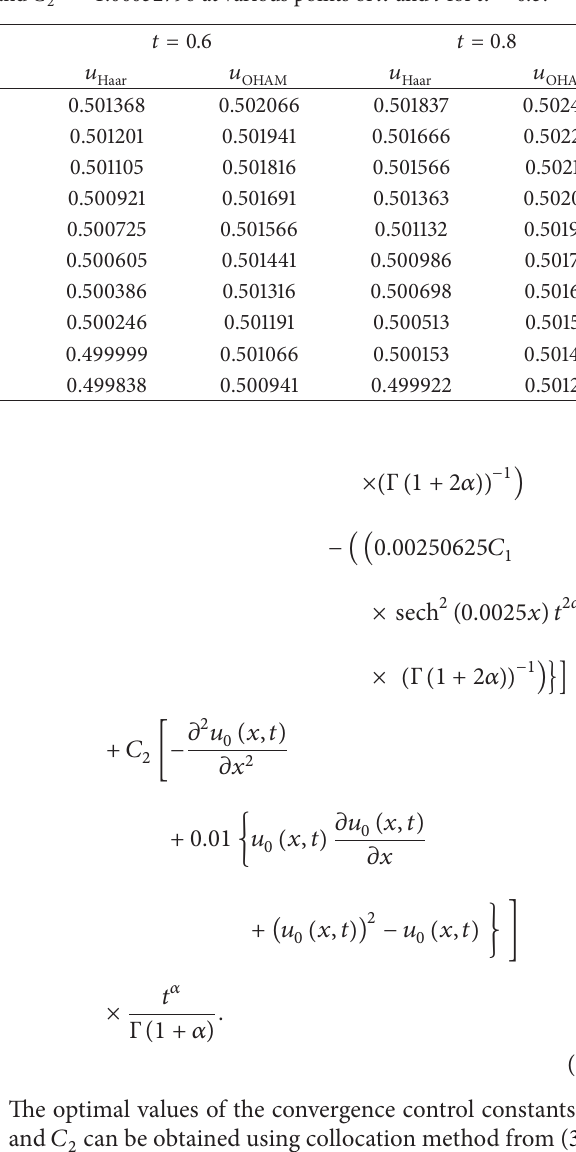
Table 4: The approximate solutions of fractional order Burgers-Fisher equation (35) using Haar wavelet method and three terms for second- order OHAM with convergence control parameters 𝐶 1 = 0.000163239 and 𝐶 2 = −1.00032796 at various points of 𝑥 and 𝑡 for 𝛼 = 0.5 .